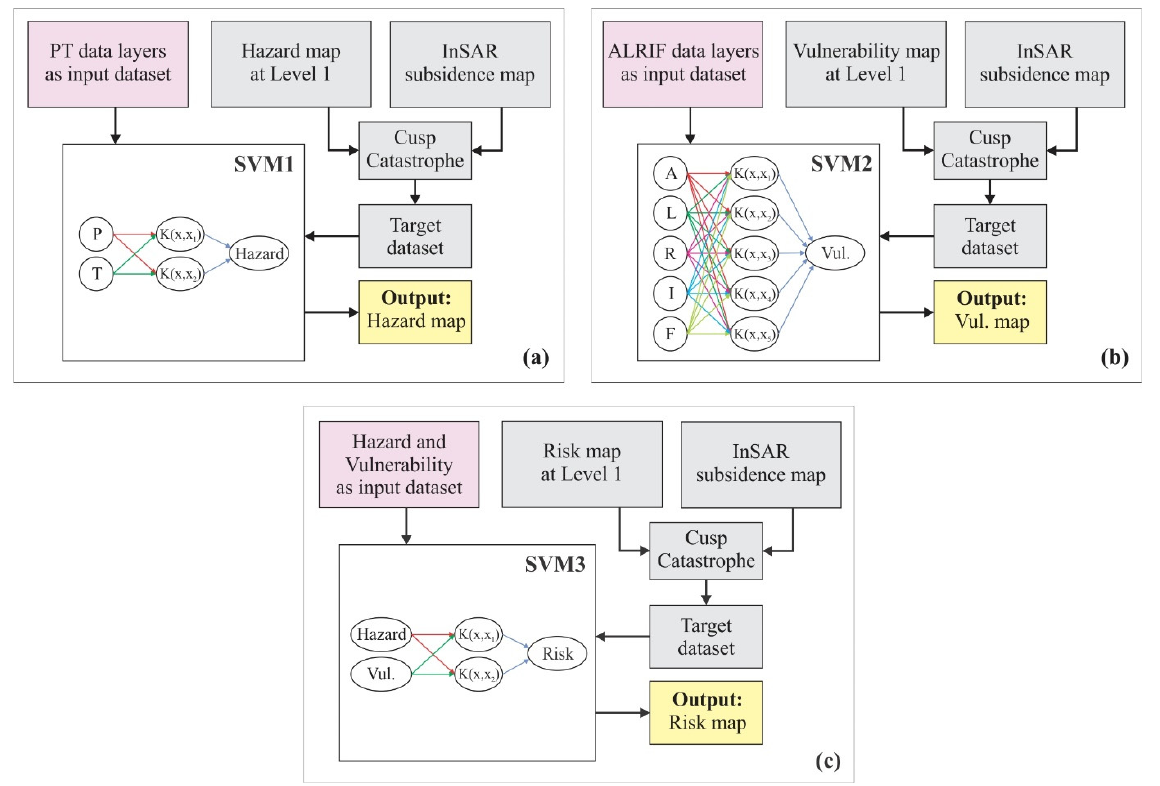
Figure 1. Methodological flowchart for mapping: ( a ) supervised hazard; ( b ) supervised vulnerability; and ( c ) supervised risk.